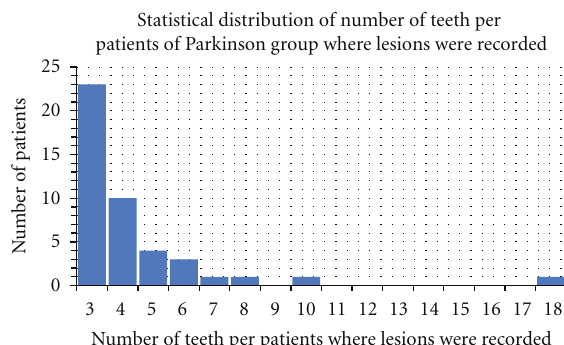
Figure 4: Number of caries recorded in PD